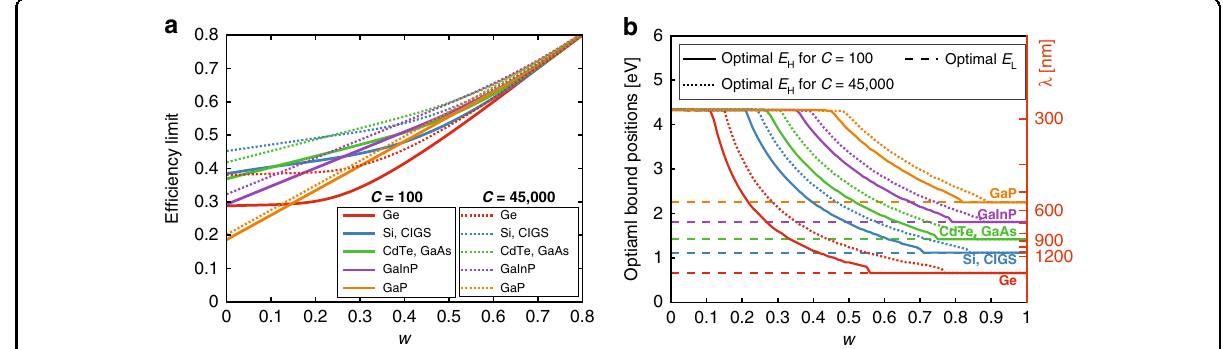
Fig. 10 a Limits of total effective ef fi ciency and b optimal spectral-splitting fi lters for different common PV cell